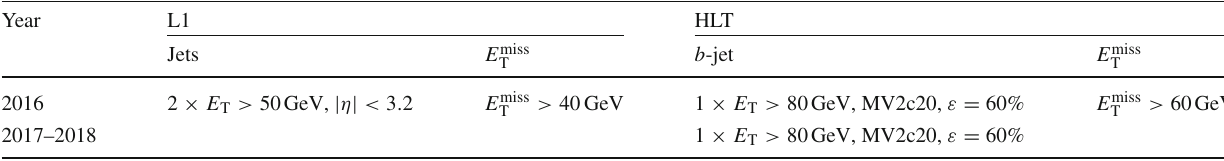
Table 7 Details, by year, of the lowest-threshold unprescaled triggers giving a b -jet plus missing transverse momentum ( E miss minimum E miss